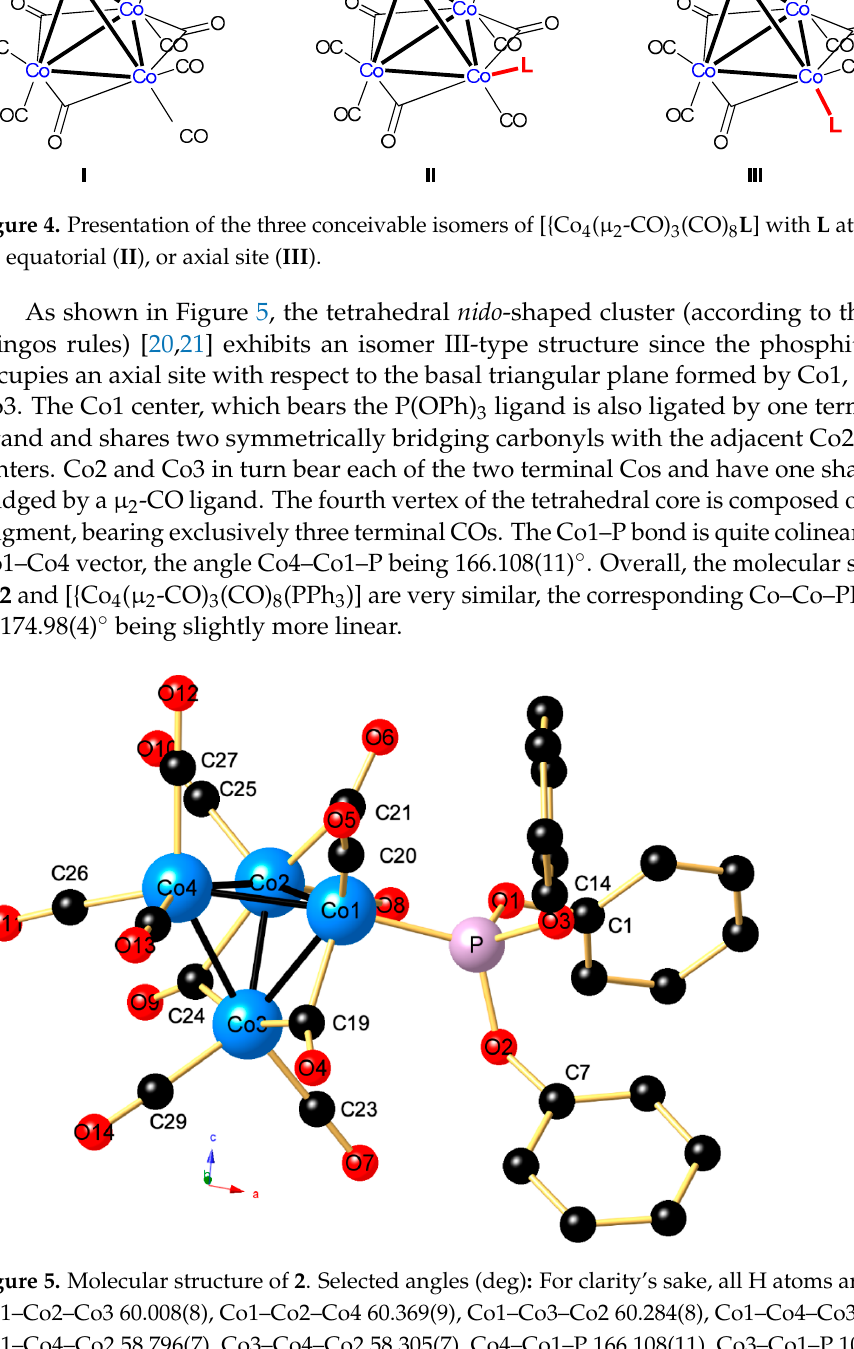
Figure 3. 13 C{ 1 H} NMR spectrum (100.62 MHz, CDCl 3 ) of compound 2 at 25 °C.